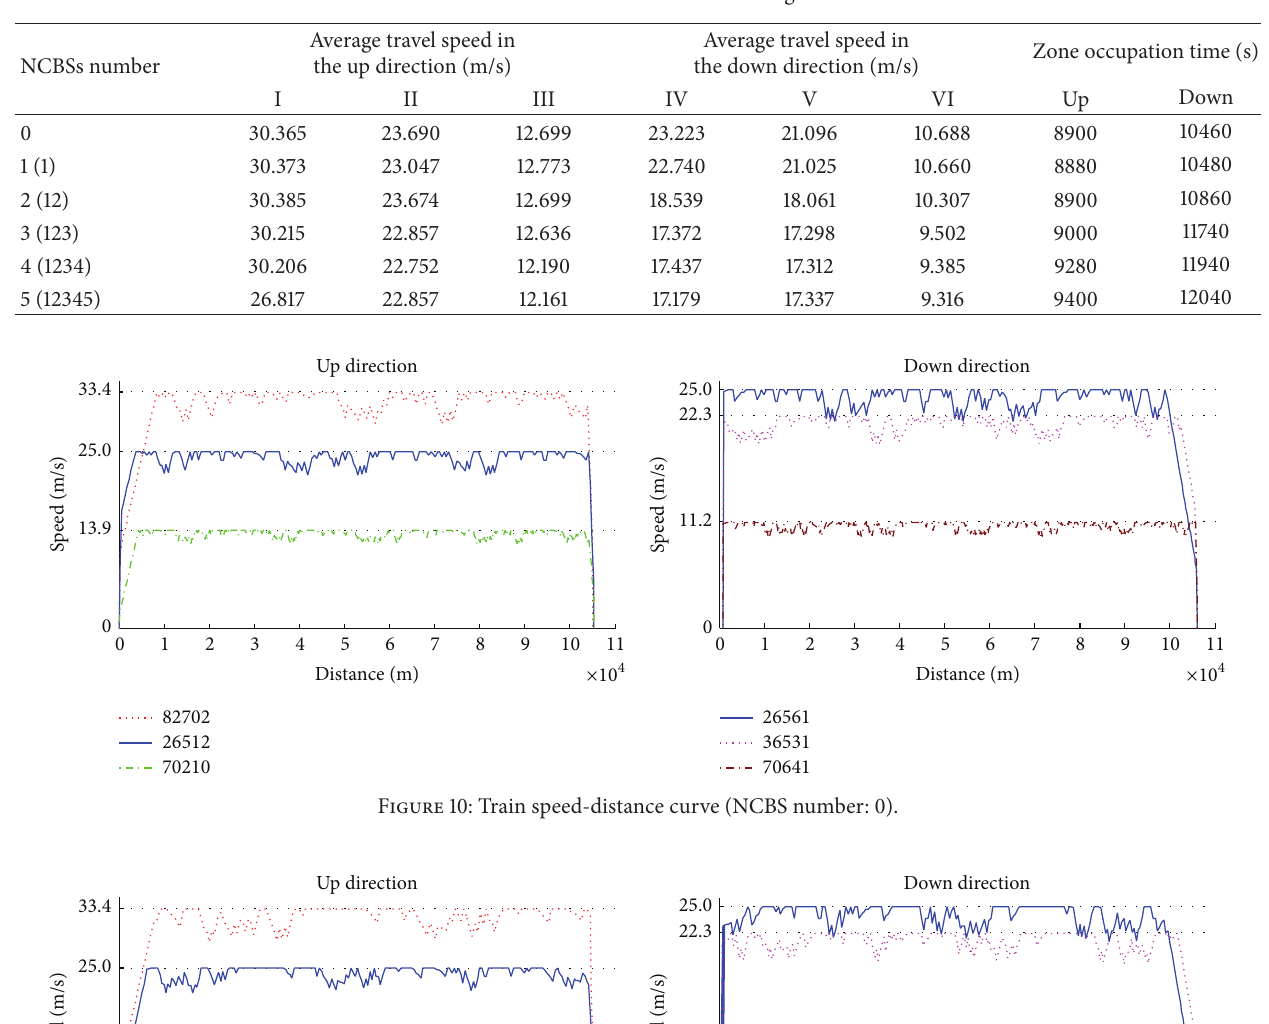
Table 4: Results for different NCBSs setting number.